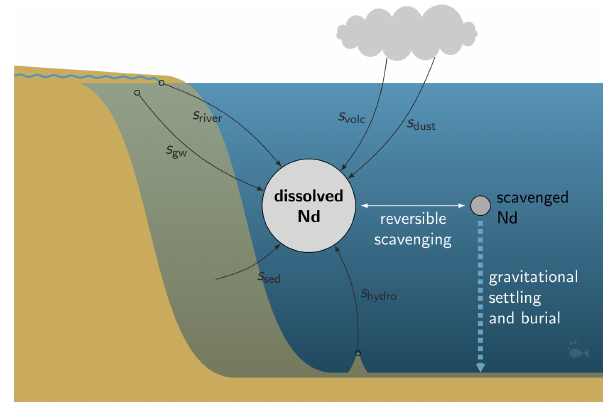
Figure 1. Diagram of the Nd cycle model as implemented in GNOM v1.0. External sources of dissolved Nd are represented by black arrows. Localized sources, rivers, groundwater, and hy- drothermal vents are indicated by a small circle at the origin of their respective arrows. A fraction of Nd is reversibly scavenged and pumped downwards. A fraction of scavenged Nd that reaches the sediments is buried in the sediments and removed from the sys- tem. Nd is also continuously transported by the ocean circulation model (not represented in the